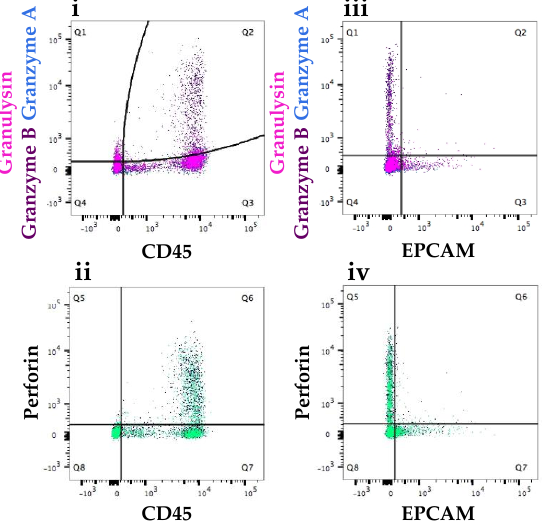
Figure 7. Expression of granzyme A, granyme B, granulysin and perforin in CD45 positive cells and EPCAM positive cells in population 1 in a participant recovering from a non-breast related surgery. Dot plots revealed increased number of CD45 + cells ( i , ii ) expressing the immune proteins compared with EPCAM + cells ( iii , iv ). Expression of the immune proteins in the EPCAM positive cells was low and similar in both participant populations.